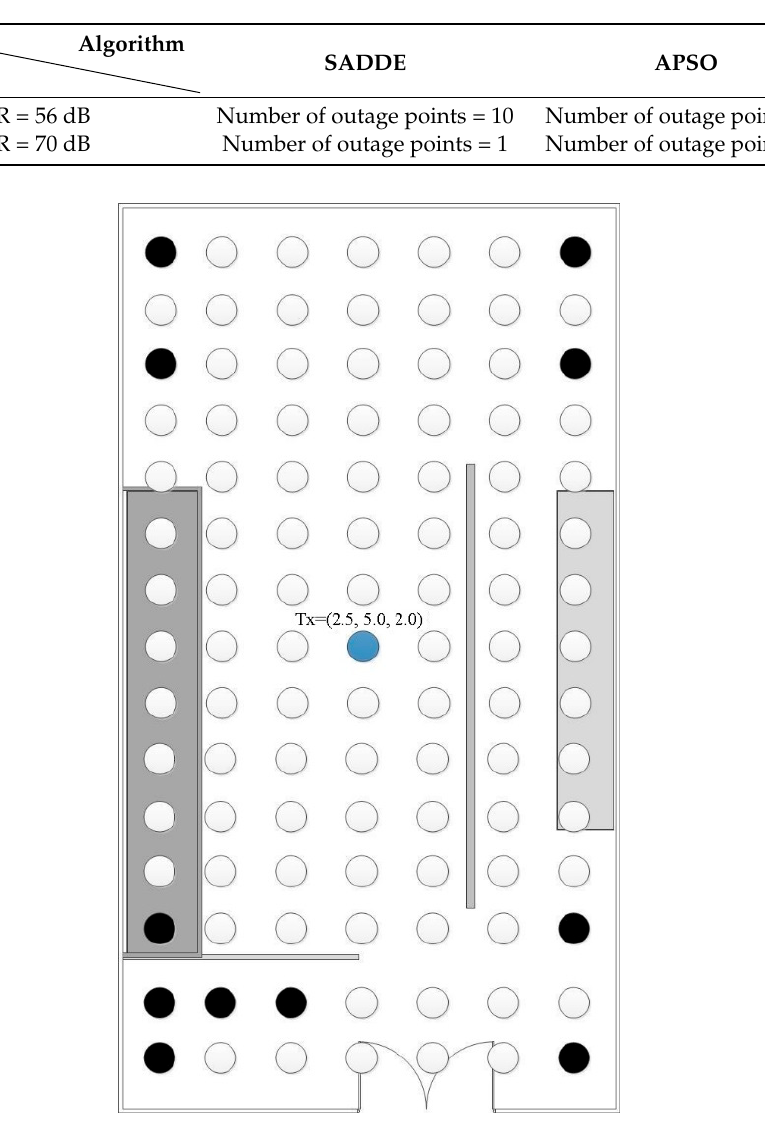
Table 1. Simulation setup. Table 2. Performance comparison for SADDE and APSO.